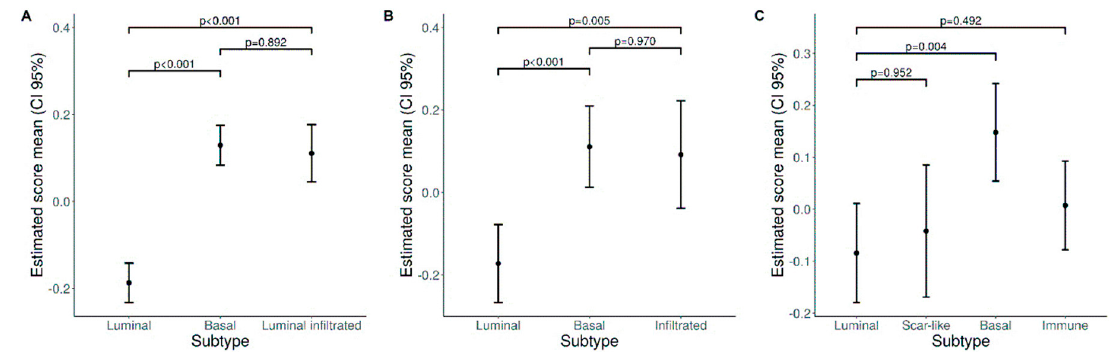
Figure 8. Neutrophil gene signature in UBC datasets. Plots show estimated mean score values and corresponding 95% confidence intervals for neutrophil GSE scores in bladder subtypes ( A TCGA, B GSE32894, C GSE124305). Pairwise comparisons p-values were computed from linear models and adjusted for multiple comparisons.